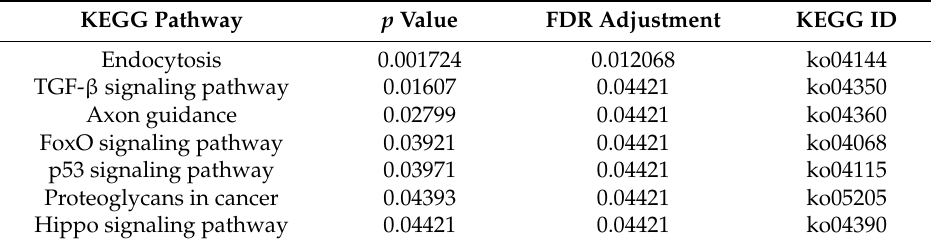
Table 3. Target genes of miR-454-3p by KEGG pathway